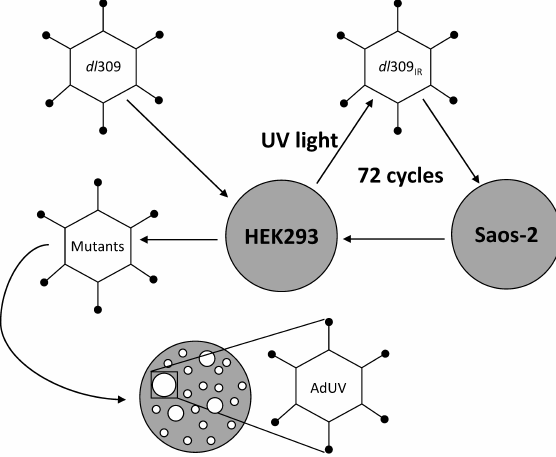
Figure 1. The repeated UV irradiation and cancer selection of AdUV. Ad5 dl 309 was initially amplified in HEK293 cells prior to UV-­‐‑irradiation. Irradiated viruses ( dl 309 IR ) were then selected in Saos-­‐‑2 cancer cells which limit adenovirus replication. Viruses were then harvested from Saos-­‐‑2 cells and amplified in HEK293 cells before subsequent cycles of UV irradiation. After 72 cycles of UV irradiation and cancer selection, AdUV was isolated by plaque purification from a large plaque formed upon Saos-­‐‑2 cells.